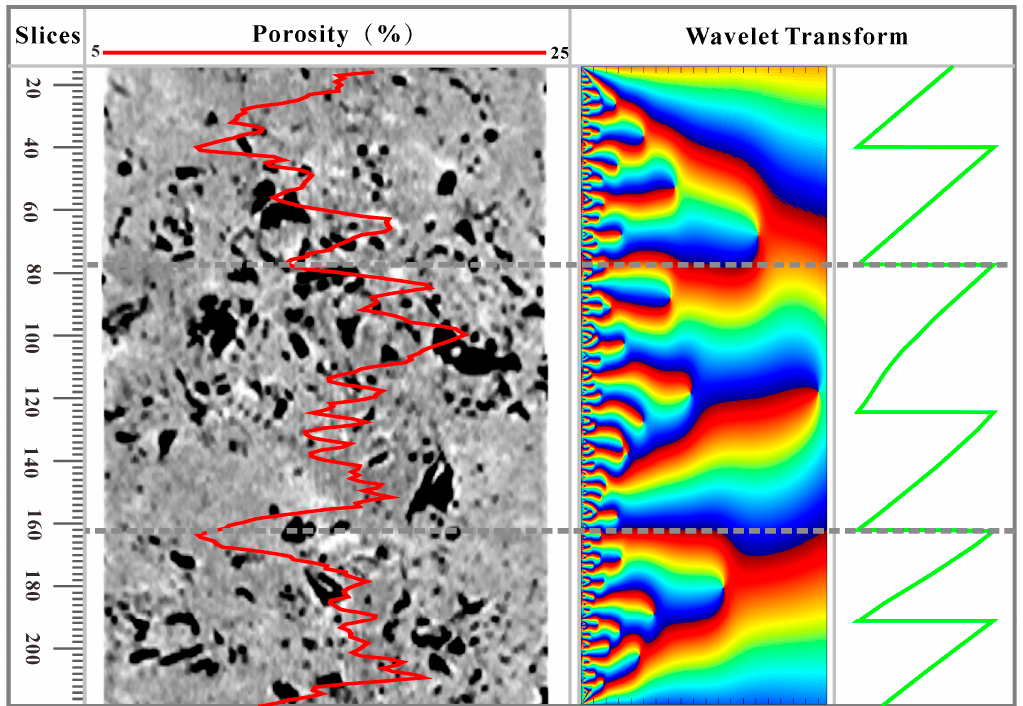
Figure 11. Identification of the porosity cyclicity based on complex wavelet transform. The red line is porosity and the green line is the cycles of porosity.